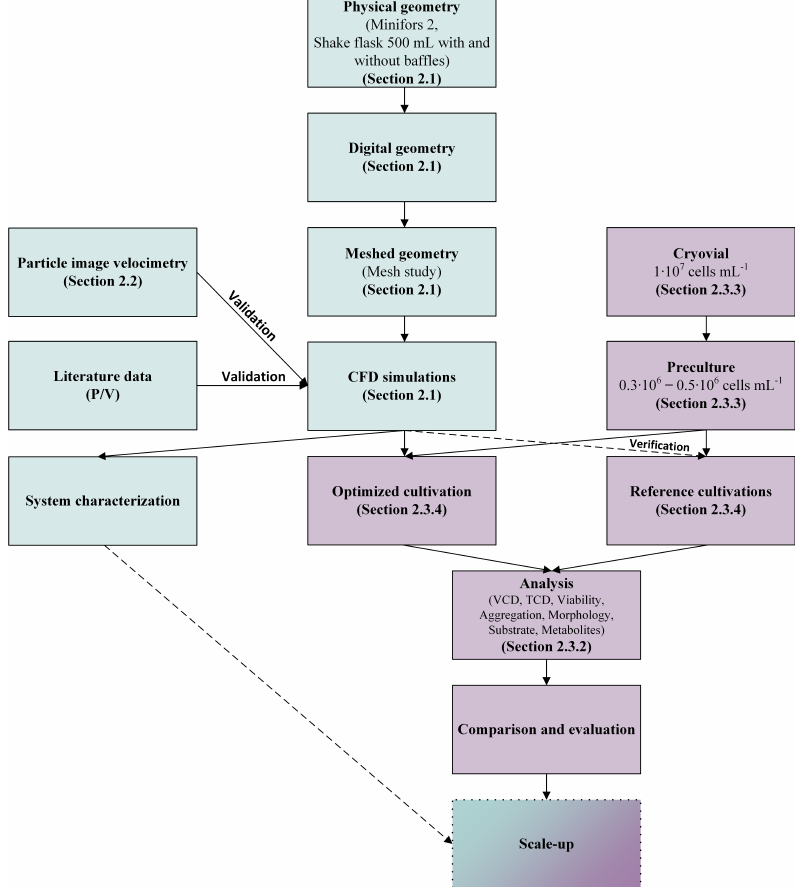
Figure 1. Graphical representation of the experiments carried out; the most important steps and the section in which the methods are described in detail are listed. Teal represents procedural steps and violet represents those with a focus on cell culture technology. The dot-framed step scale-up is not part of this study. However, the information gained here serves as a basis for a scale-up